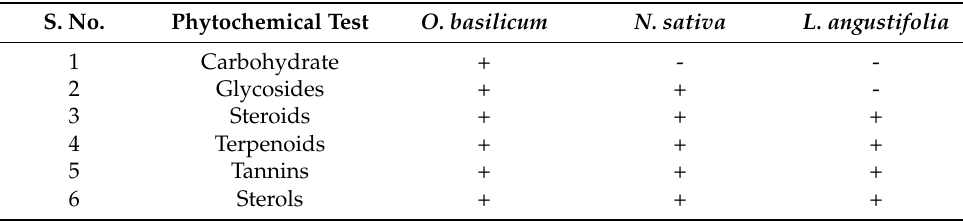
Table 2. Phytochemical analysis of basil, black seeds and lavender EOs. S.